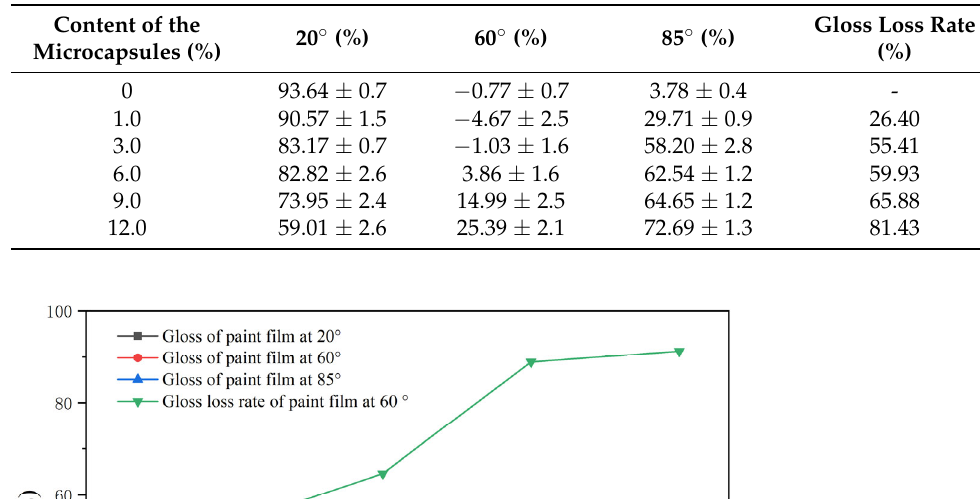
Figure 14. The trend of the chromaticity value and color difference value. Table 14. Gloss and extinction rates of the paint films.